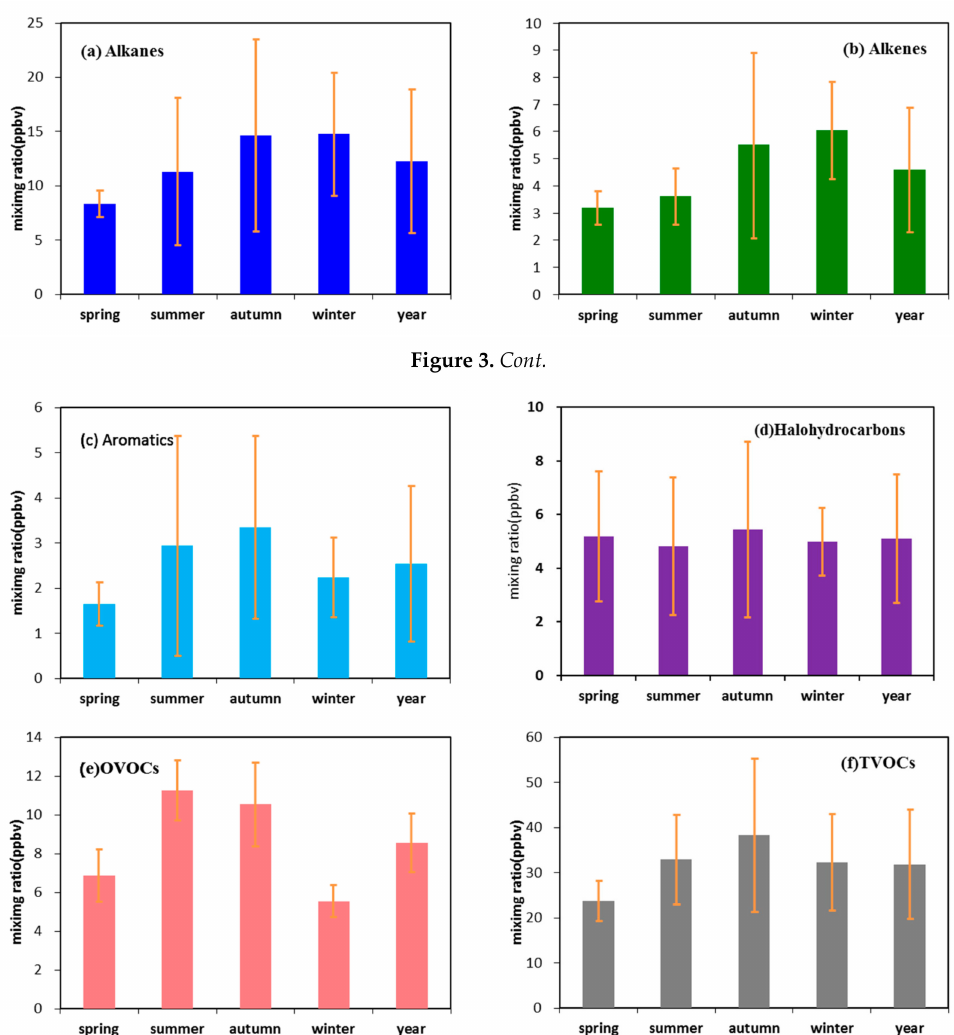
Figure 3. The seasonal variation of alkanes, alkenes, aromatics, halohydrocarbons, OVOCs and TVOCs. The 72 h backward transport trajectory of-airflow over Wuhan at 9:00 a.m. and 15:00 p.m.